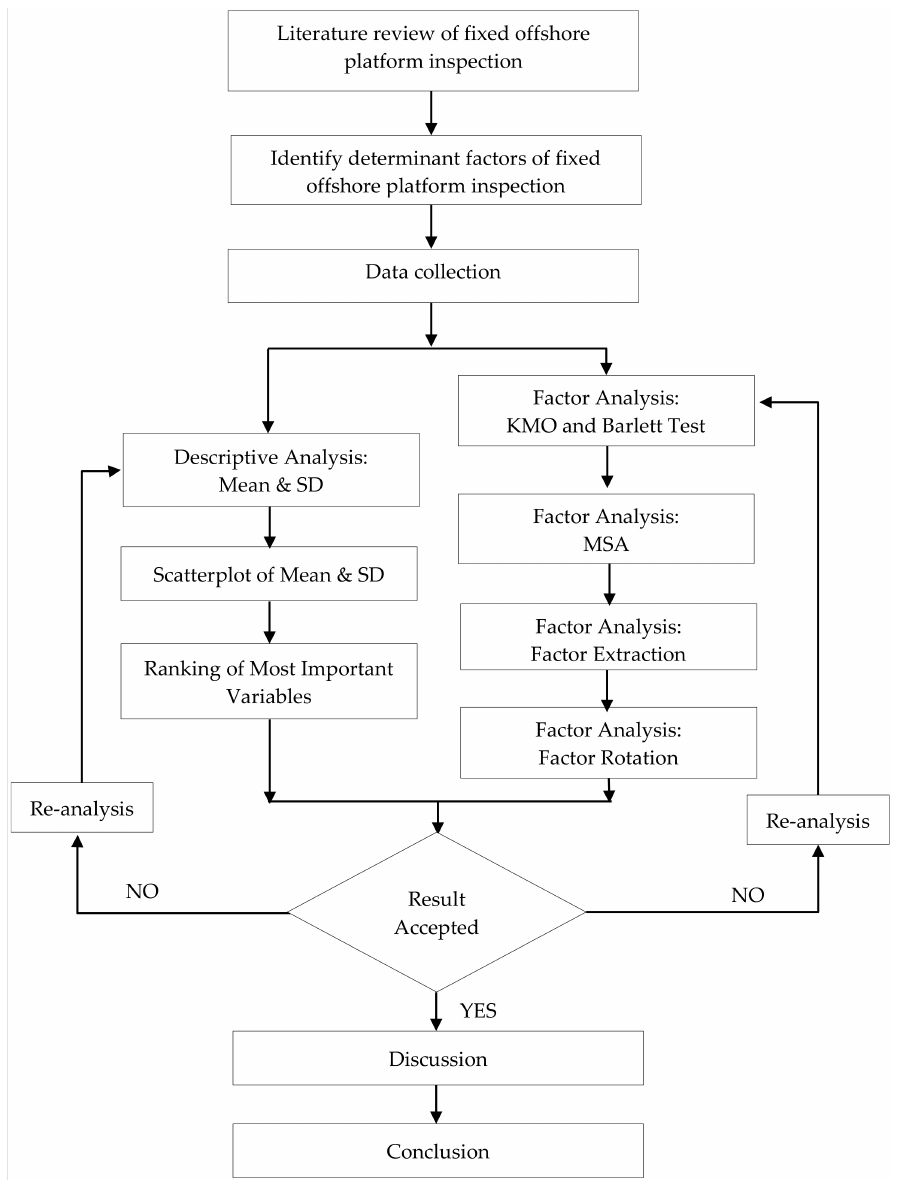
Figure 1. Flow chart of research